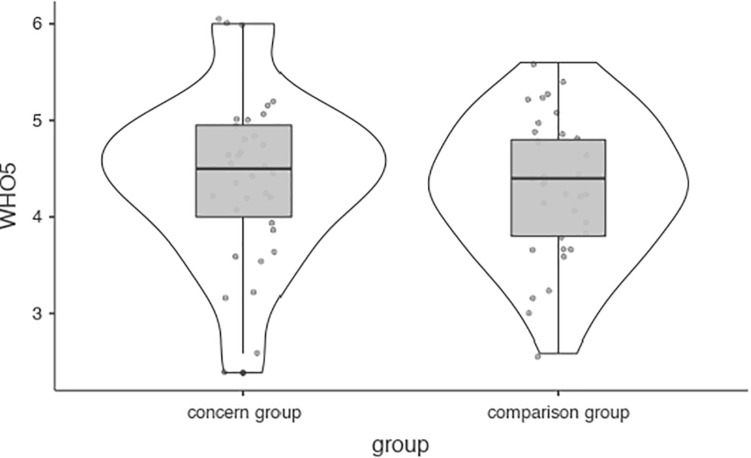
Cued task switching task.